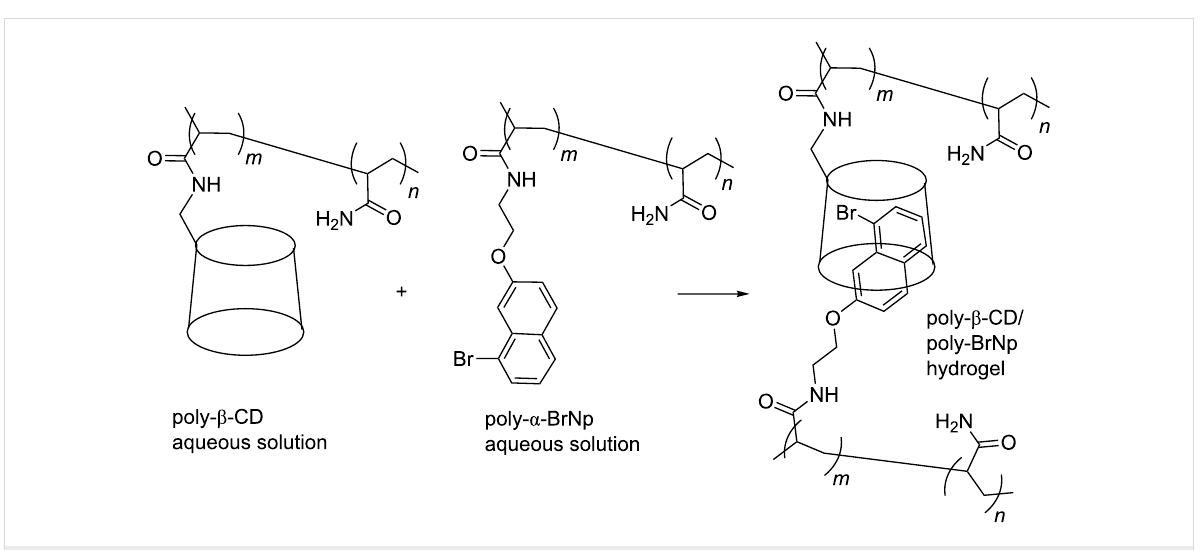
Figure 22: Aqueous solutions of the polymers poly- β -CD and poly- α -BrNP form the poly- β -CD/poly- α -BrNP hydrogel [109].